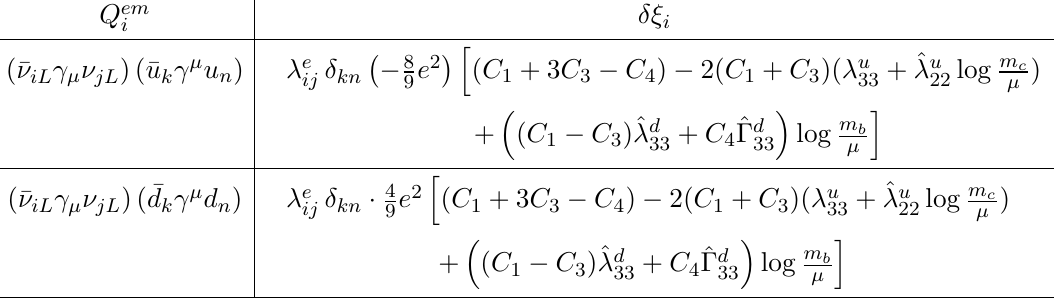
Table 7 . Operators Q em